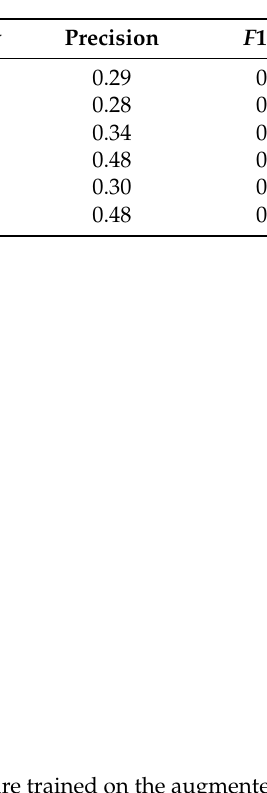
Figure 6. ROCs of the deep-learning models that are trained on the original training set. Table 5. The performance of the deep-learning models on mass classification when trained on the augmented training set.